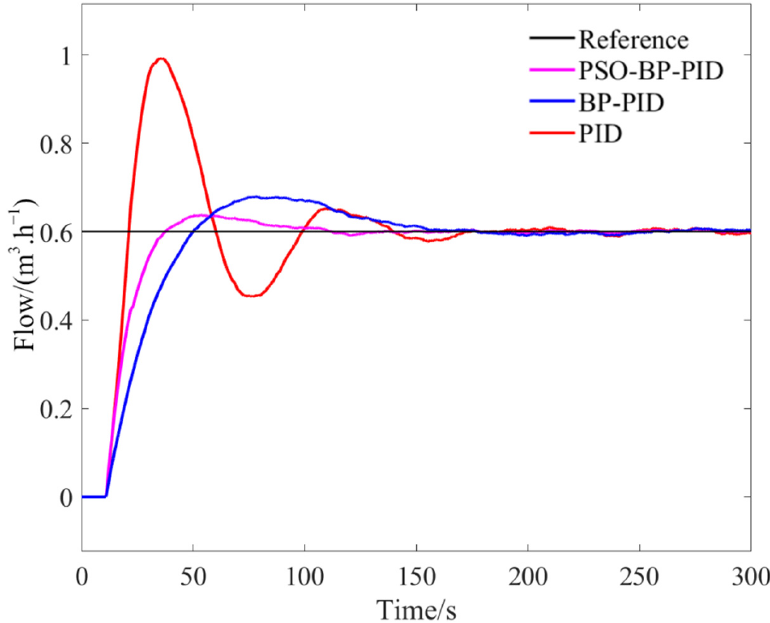
Figure 13. Regulation curves of the three controllers at a fertilizer application flow rate of 0.6 m 3 /h. Table 3. Comparison of the dynamic performance of three controllers at fertilizer application flow rate of 0.6 m 3 /h.